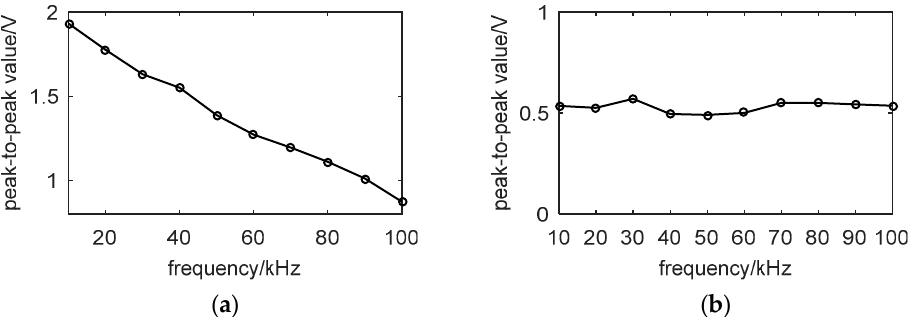
Figure 12. Change of testing signal amplitude with frequencies: ( a ) longitudinal crack; ( b ) transverse crack.